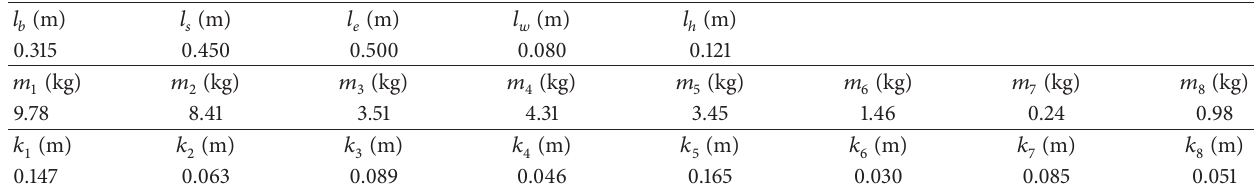
Figure 20: Scene in obstacle avoidance experiment. Table 1: Values of link parameters.